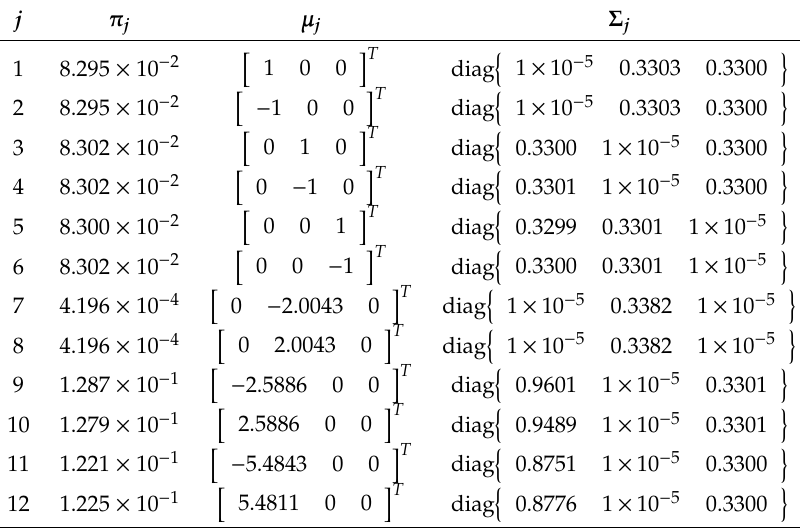
Table 2. Calculation results of key parameters of